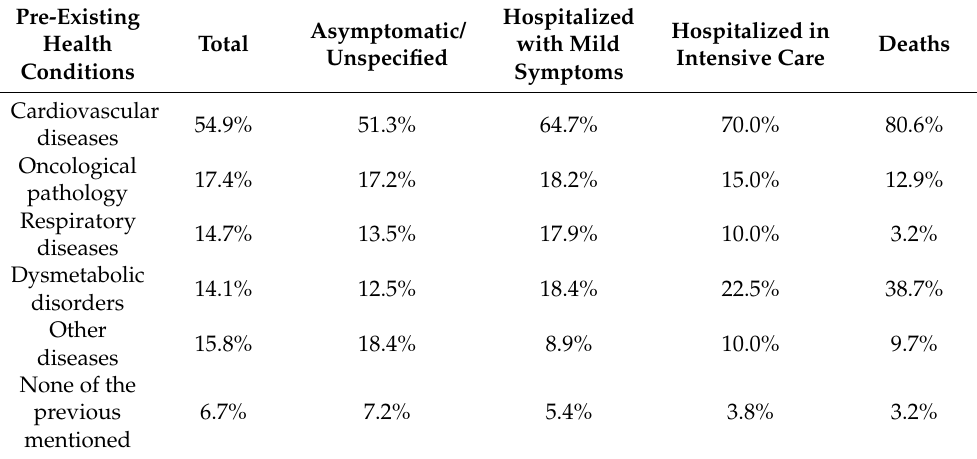
Table 4. Pre-existing health conditions in the total sample and according to the disease outcome. Multiple-choice question 1